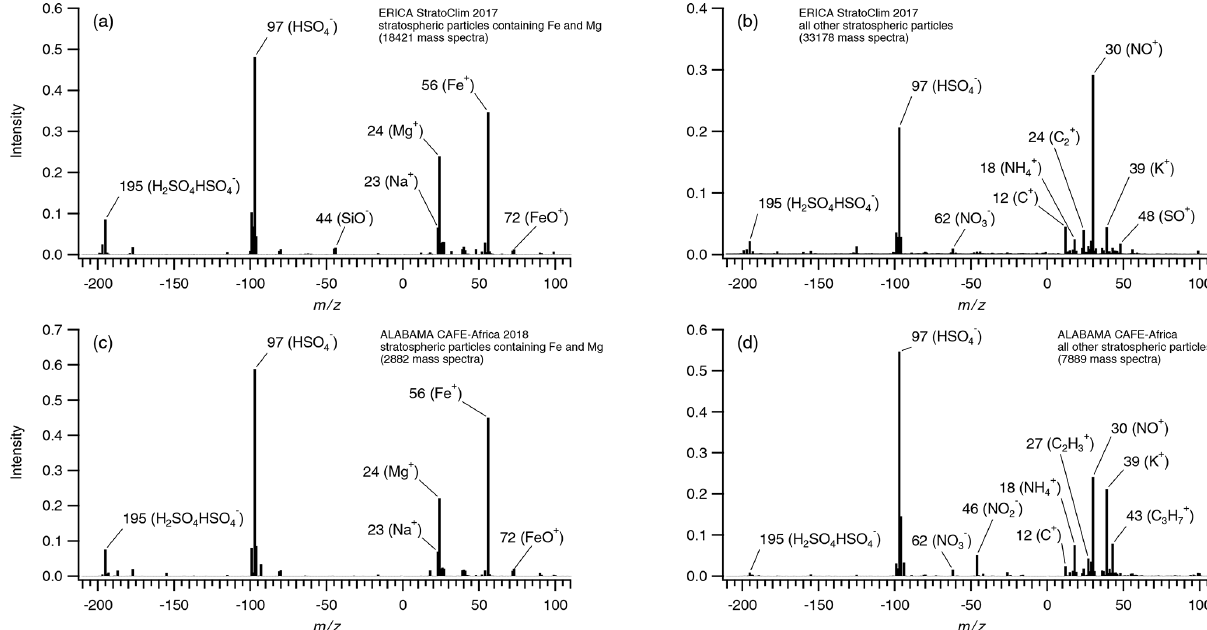
Figure 2. Mean mass spectra of stratospheric particles (PV > 4PVU). (a, b) StratoClim 2017 (ERICA); (c, d) CAFE-Africa 2018 (AL- ABAMA). Panels (a) and (c) show the averaged mass spectra of particles of which the positive mass spectra are dominated by iron (Fe + and FeO + ) and magnesium (Mg + ). The two anion as well as the two cation mass spectra of the Mg- and Fe-dominated particles correlate between the instruments with r 2 = 0.97. Panels (b) and (d) show the averaged mass spectrum of all other stratospheric